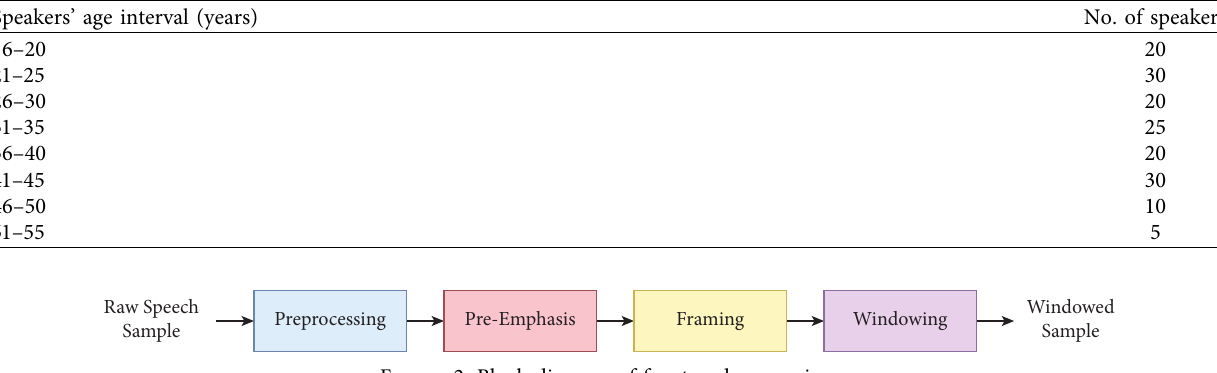
Figure 2: Block diagram of front-end processing.